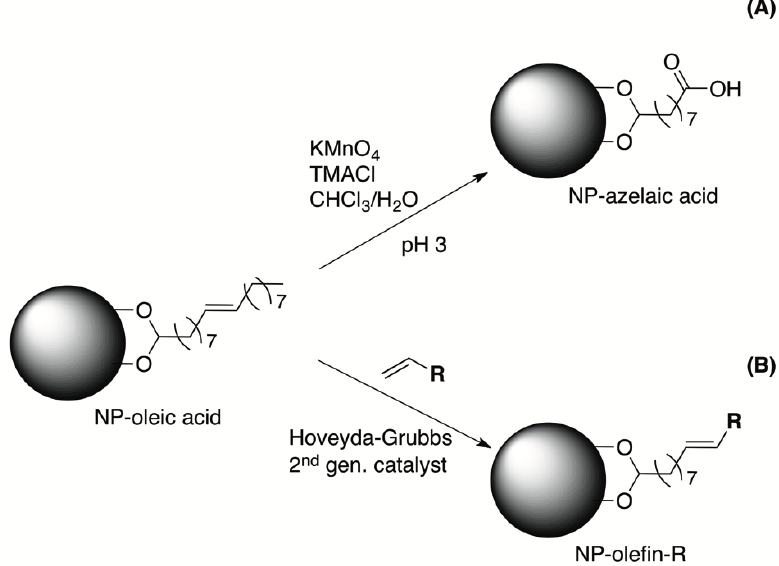
Figure 6. Direct chemical modification of the surfactant for oleic acid-coated IONPs,